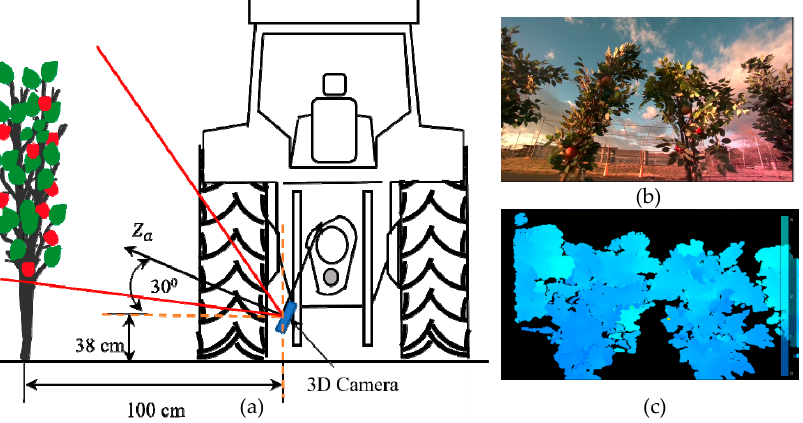
Figure 11. ( a ) A 3D camera at 30° orientation, ( b ) RGB stream corresponding to the 30° camera orientation angle, and ( c ) a depth stream.